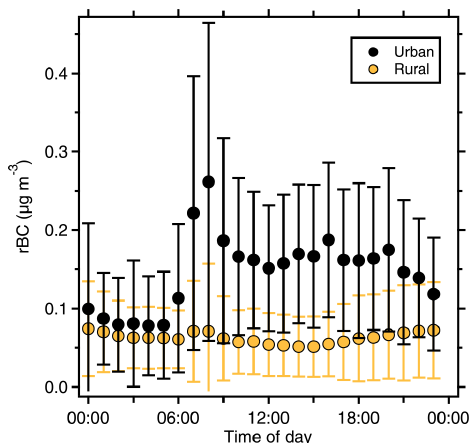
Figure 2. Diurnal cycles of rBC mass concentrations ( ± 1 σ ) from the urban and rural sites as measured by the SP2. Values are av- erages of data collected during 34 (rural) and 41 (urban) days of sampling.